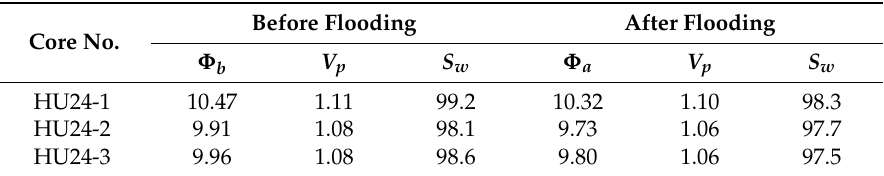
Table 6. Brine saturations of cores before MNR measurements.